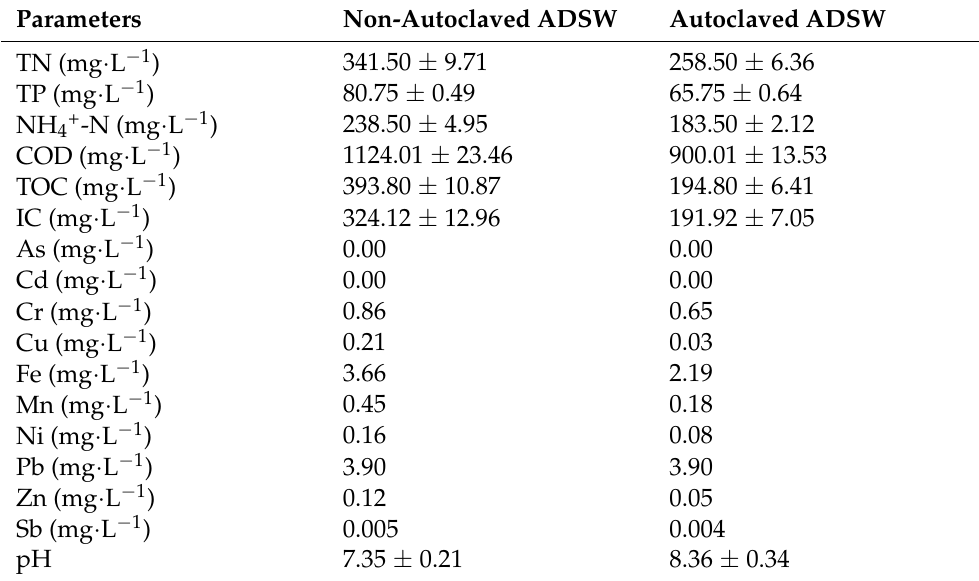
Table 1. Compositions of non-autoclaved and autoclaved